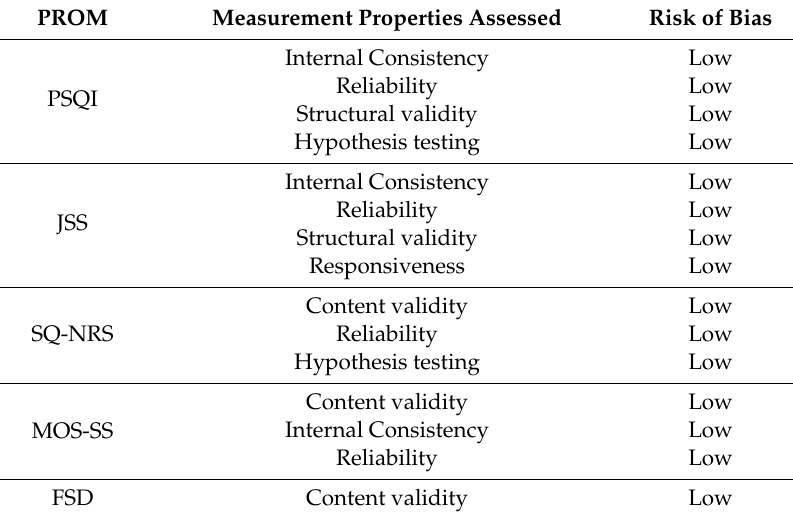
Table 2. Risk of Bias